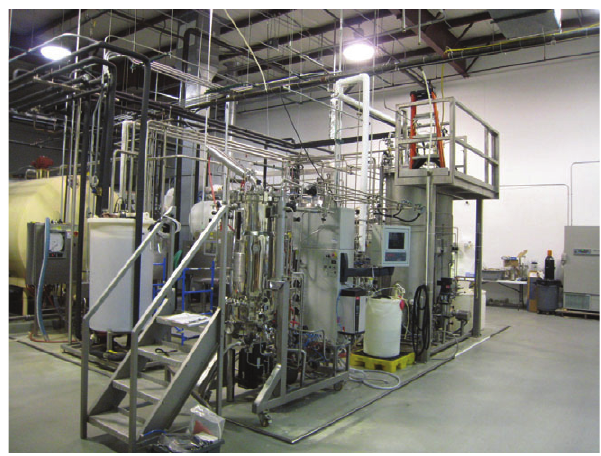
Figure 3 Green Biologics pilot plant in Gahanna, Ohio,